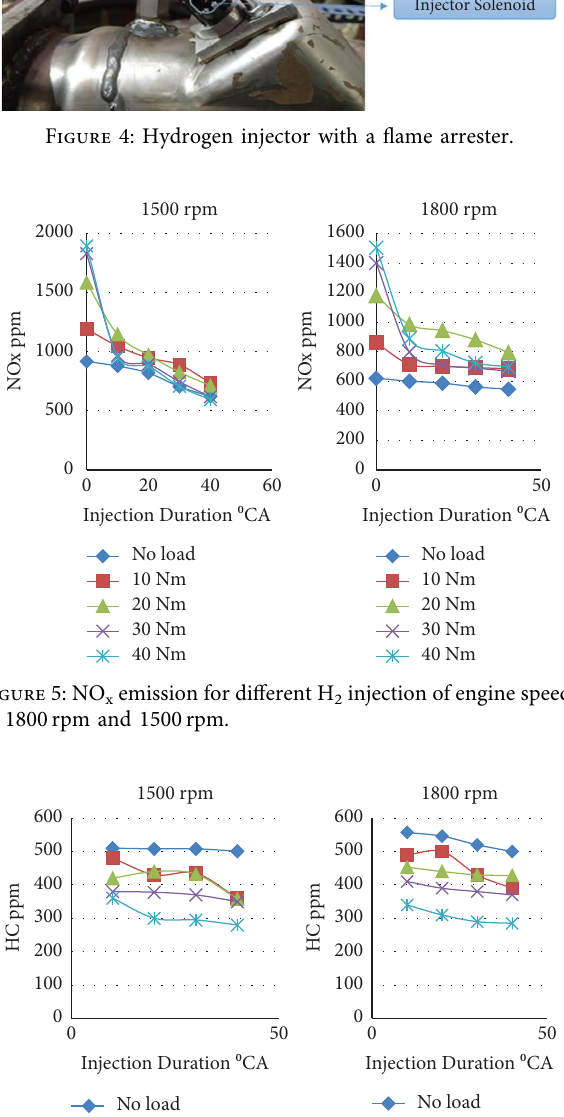
2 injection of engine speeds